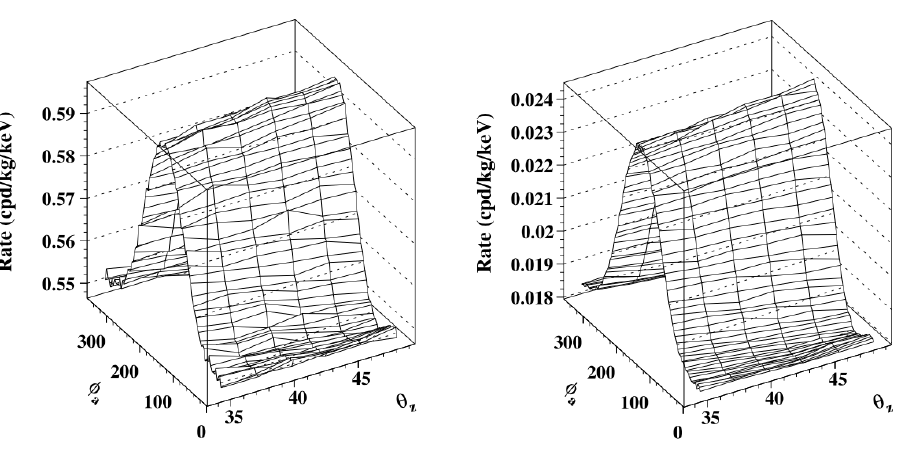
Figure 6. Example of expected rate for the case of a dark matter particle of 50 GeV mass inducing nuclear recoils and ξσ p = 5 × 10 − 5 pb in the scenario considered in [48]. The dependences of the expected rates in the (2–3) keV (left) and (6–7) keV (right) energy windows are shown as a function of the detector’s (or Earth’s) possible velocity directions. There is a strong dependence on the “polar– azimuth” φ a that induces a diurnal variation of the rate [50]. See text for details. Reprinted from Ref. [48] with Copyright Permission from The European Physical Journal